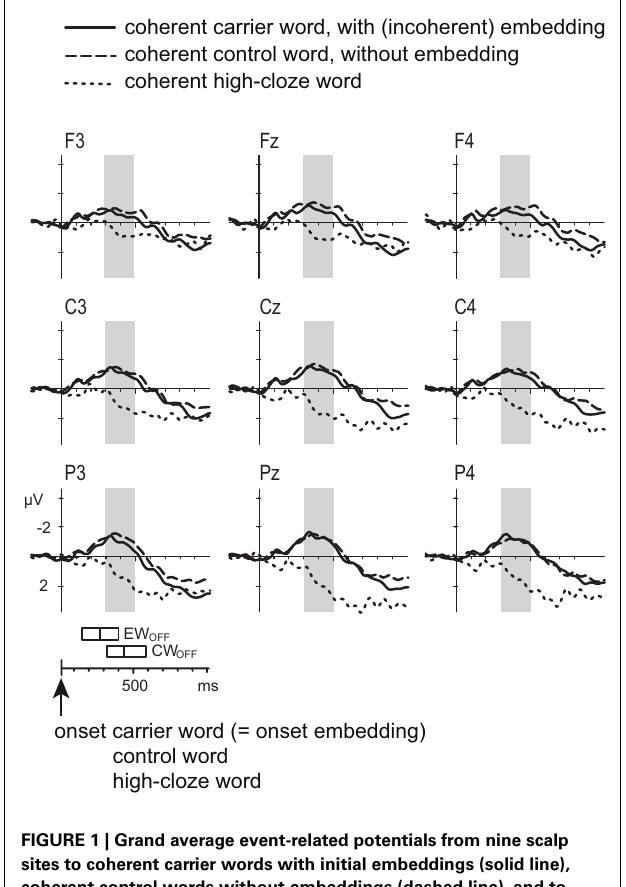
FIGURE 1 | Grand average event-related potentials from nine scalp sites to coherent carrier words with initial embeddings (solid line), coherent control words without embeddings (dashed line), and to coherent high-cloze words (dotted line), after baseline correction in the 200-ms prestimulus interval, time-locked to the onset of the carrier/control words, which corresponds to the onset of the initial embeddings. In these and all other figures, the time axis is in milliseconds, negative polarity is plotted upward, and waveforms are filtered (5Hz high cut-off, 12dB/oct) for presentation purposes.The bars in the lower left corner show the offset of the embedded words (EW OFF ), and the offset of the carrier words (CW OFF ).The start of the bar corresponds to the minimal value, the end to the maximal value and the middle to the